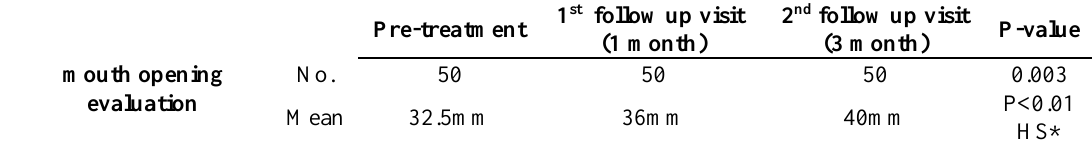
Table 4: Maximum mouth opening (before and